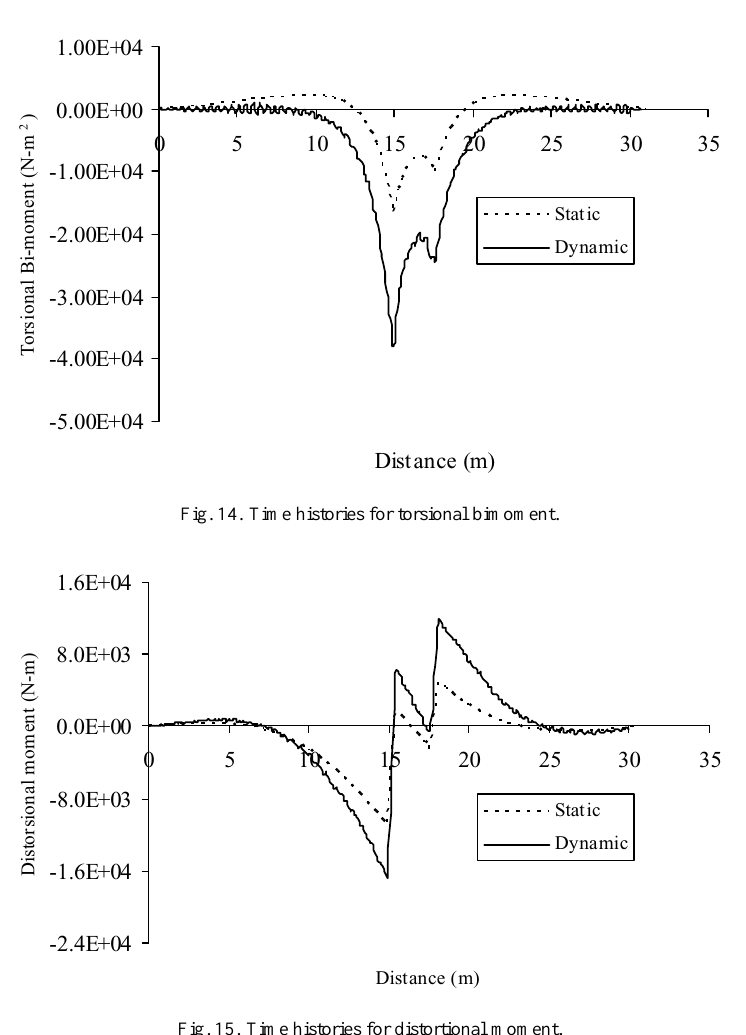
Fig. 15. Time histories for distortional